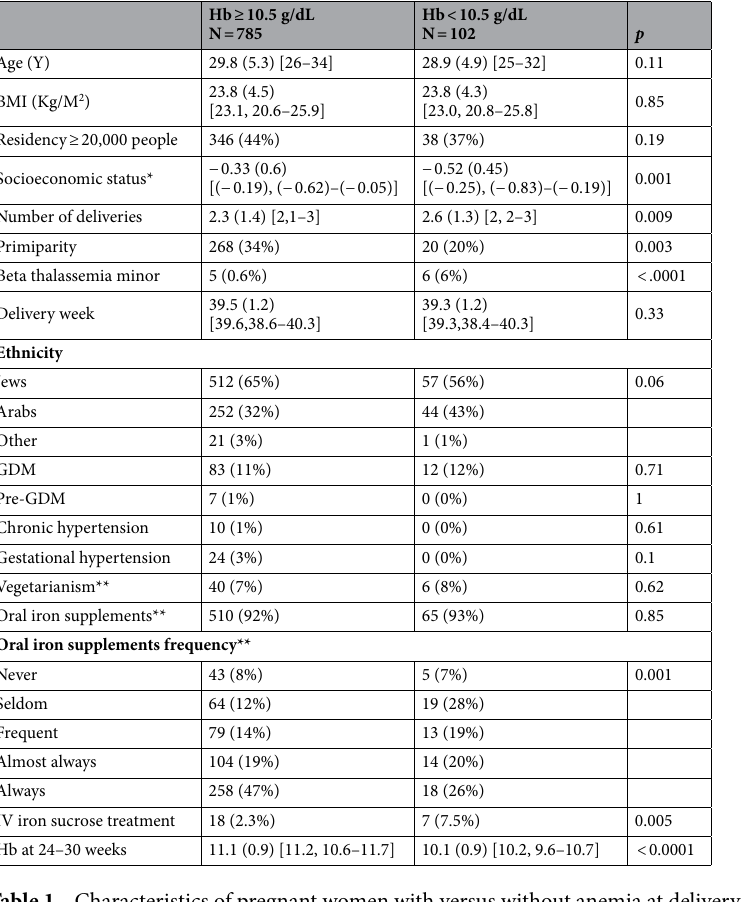
Table 1. Characteristics of pregnant women with versus without anemia at delivery. Values are presented as median [Interquartile range] or number (percent). *Socioeconomic status was ranked using the 2015 Socio- Economic index of the local municipalities, which is published by the Israeli Central Bureau of Statistics. The index of 2015 is available at: URL: https:// www. cbs. gov. il/ he/ media relea se/ doclib/ 2018/ 351/ 24_ 18_ 351t1. pdf. The index is calculated by means of factor analysis, and is standardized so that the mean index value for all the local authorities is zero. The index value is the distance of the local authority from the mean value measured by standard deviation units. This index was not available for very small authorities (N = 249). **Data regarding iron supplements, iron supplements frequency, vegetarianism and IV iron sucrose treatment were missing for 264, 270, 215 and 32 women who did not answered these questions. BMI, body mass index; GDM, gestational diabetes mellitus; IV, intravenous.